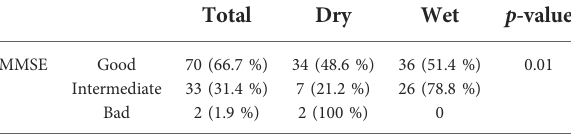
TABLE 3 Signi fi cant correlation between MMSE results and continence status, whereby dry is de fi ned as <2 ml loss of urine and wet ≥ 2 ml during the 1 h pad test one day after catheter removal (8).